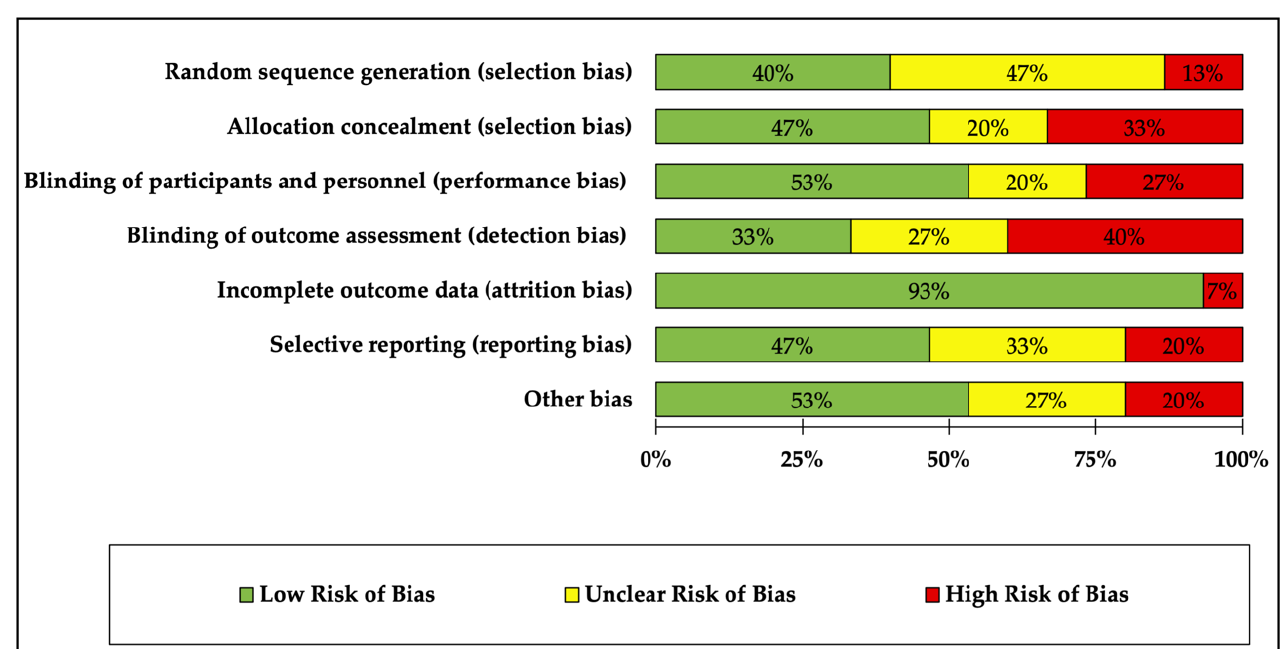
Figure 2. Assessment of risk of bias in included randomized controlled trials.